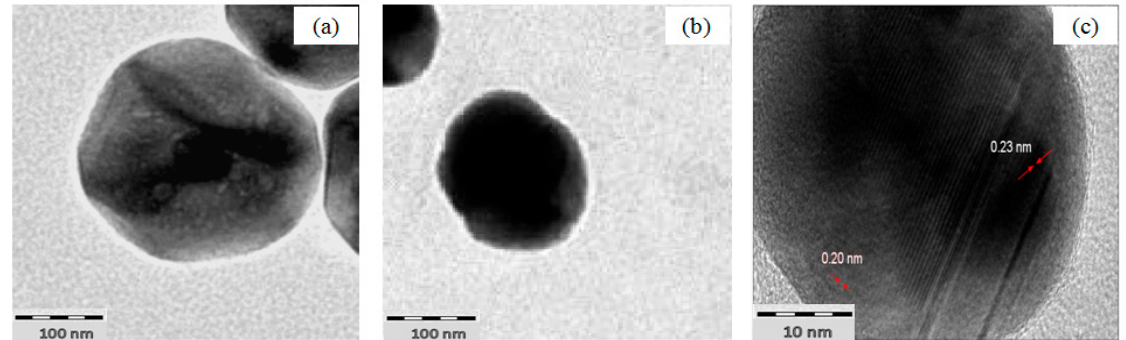
Figure 5. HRTEM images of Au-Ag bimetallic NPs for different volume of Au seed ( a ) 2.0 mL and ( b ) 5.0 mL, and ( c ) lattice spacing of Au-Ag NPs.